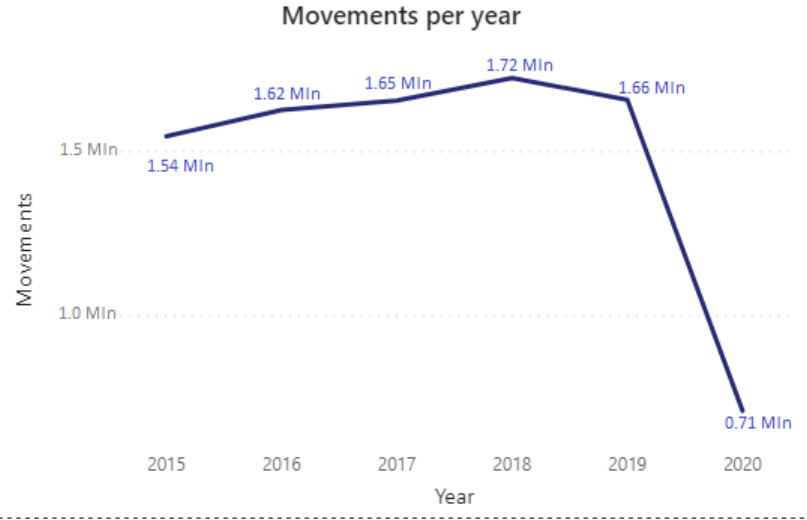
Figure 6. Yearly number of drone intrusions in Italian airports (2015–2020).